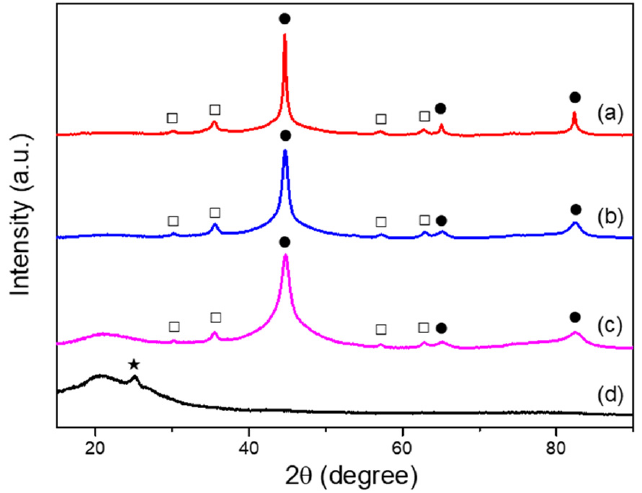
Figure 5. X-ray diffraction patterns of (a) Pure Fe, (b) Fe@PANI-90/10, (c) Fe@PANI-70-30, and (d) PANI. ● Fe, □ Fe 3 O 4 ★ , carbon.